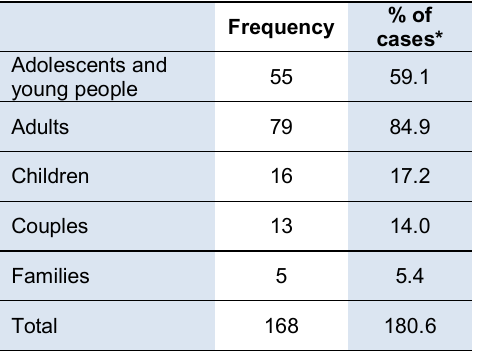
Table 8 - Main Types of psychotherapy clients. n